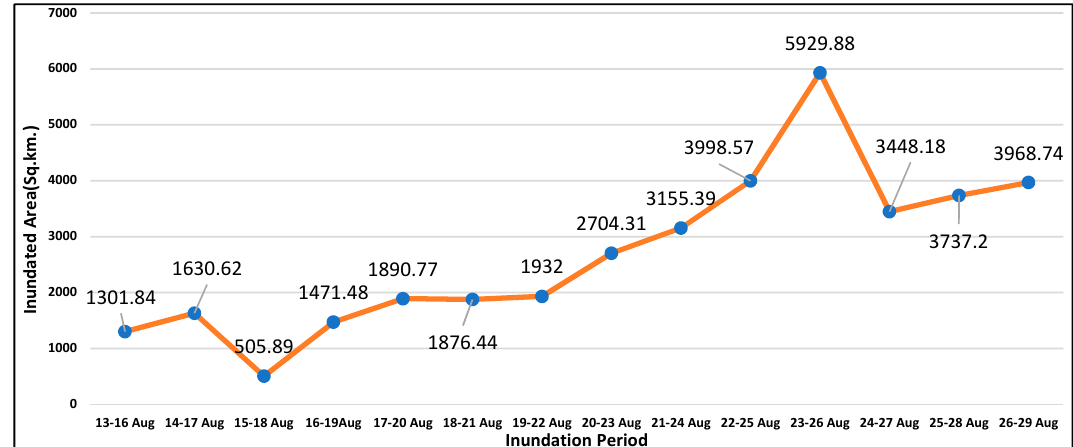
Figure A4. Four–day cumulative composite flood progressive and regressive pattern during 13–29th Aug, 2017.